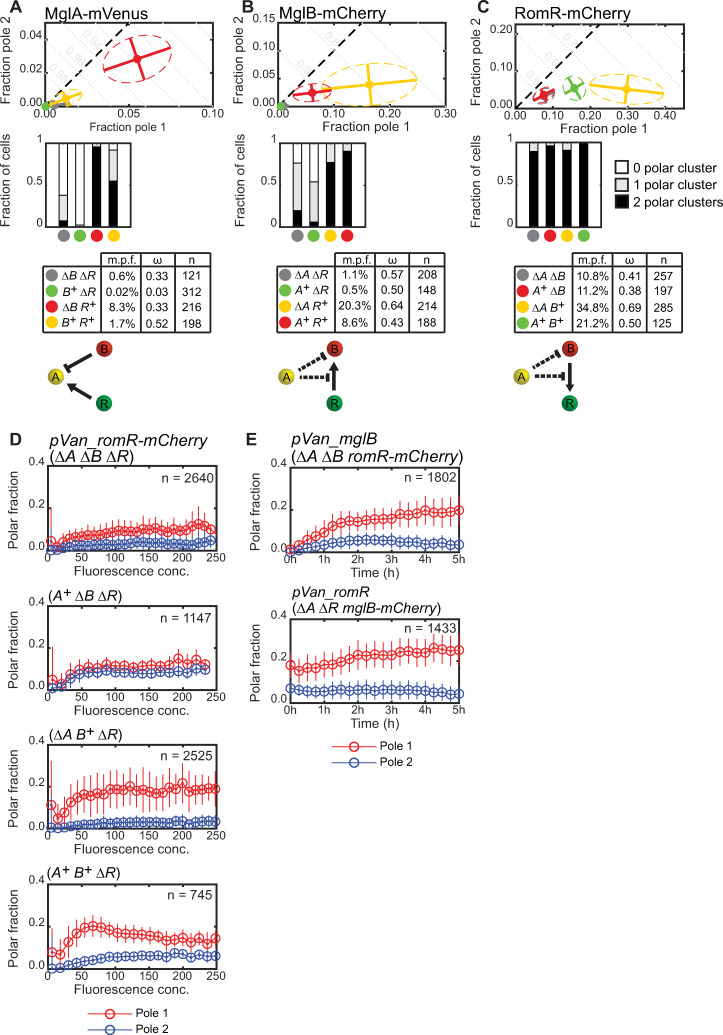
Rebuilding the polarity module.A, B and C. Polar localization of MglA-mVenus, MglB-mCherry and RomR-mCherry in WT and in the absence of one or both of the other proteins. Data are presented as in Fig 2A–2C. Note that the data for the WT and double mutants are the same as in Fig 2A–2C. Fourth row, interactions inferred from the changes in polar localization. Positive interactions are represented by pointed arrows, and negative interactions by blunt arrows. Dashed lines indicate possible alternative interactions that cannot be distinguished based on the available data. D. Induction of romR-mCherry in strains of the indicated genotypes. All strains also contained ΔaglQ ΔfrzE mutations as in Fig 4A. Polar fluorescence fractions are plotted against fluorescence concentration, as described for Fig 4A. Data in the upper panel are the same as in Fig 4A. E. Induction of mglB or romR. Top, RomR-mCherry localization is plotted over time upon induction of pVan_mglB in the ΔmglA ΔmglB romR-mCherry strain. Bottom, MglB-mCherry localization is plotted over time upon induction of pVan_romR in the ΔmglA ΔromR mglB-mCherry strain. Both strains also contained ΔaglQ ΔfrzE mutations as in Fig 4A.